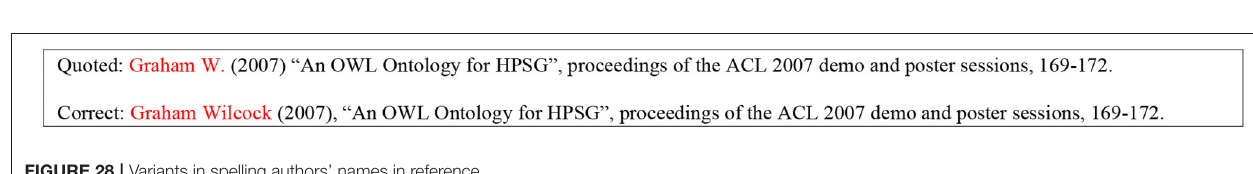
FIGURE 28 | Variants in spelling authors’ names in reference.